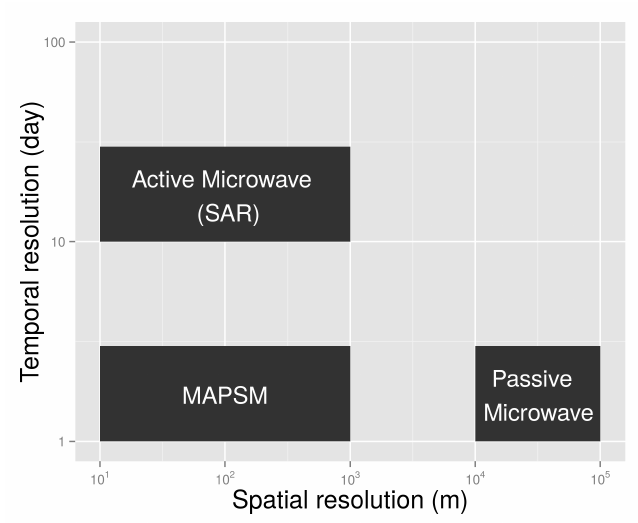
Figure 3. Spatial and temporal resolution using a logarithmic scale for the active microwave (SAR), passive microwave (SMOS, SMAP) and MAPSM soil moisture